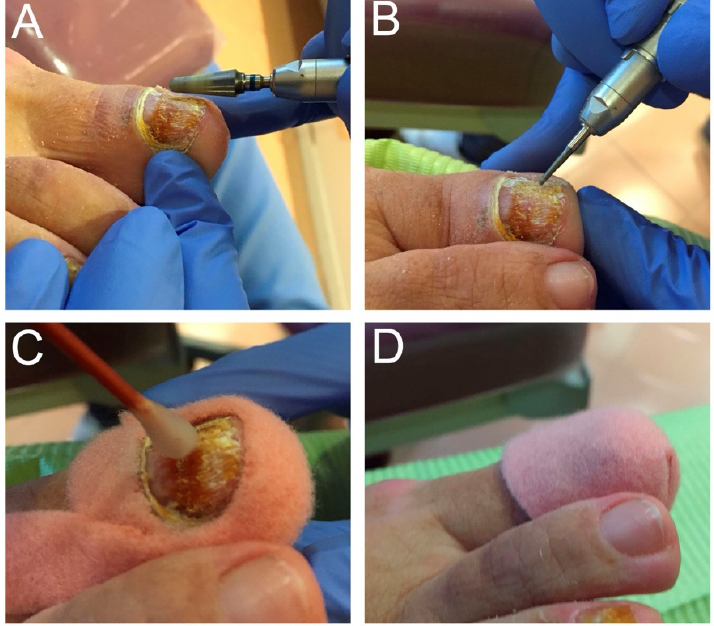
Figure 1. Treatment protocol: ( A ) ebridement of the affected part of the nail. ( B ) Pitting the nail plate. ( C ) Application of nitric acid 60% for 15 s. ( D ) Occlusive dressing.